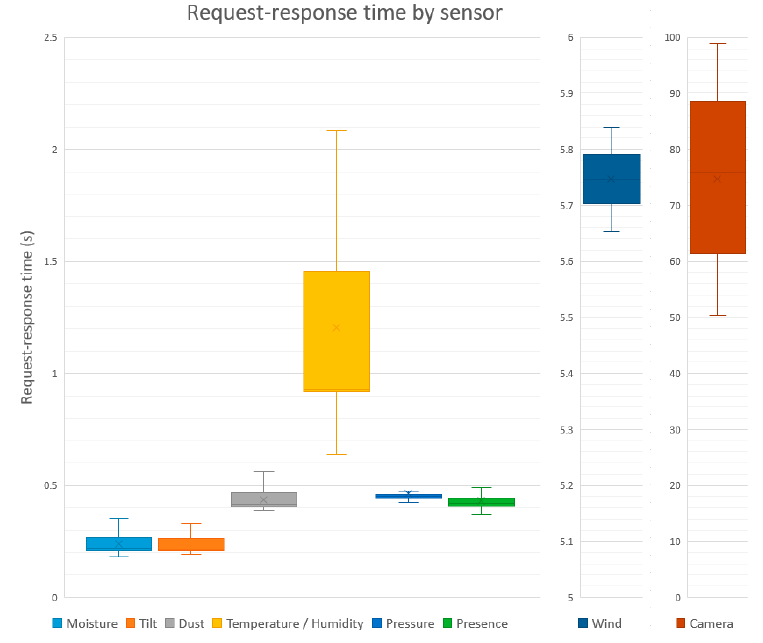
Figure 14. Box plot of Request-Response time results.